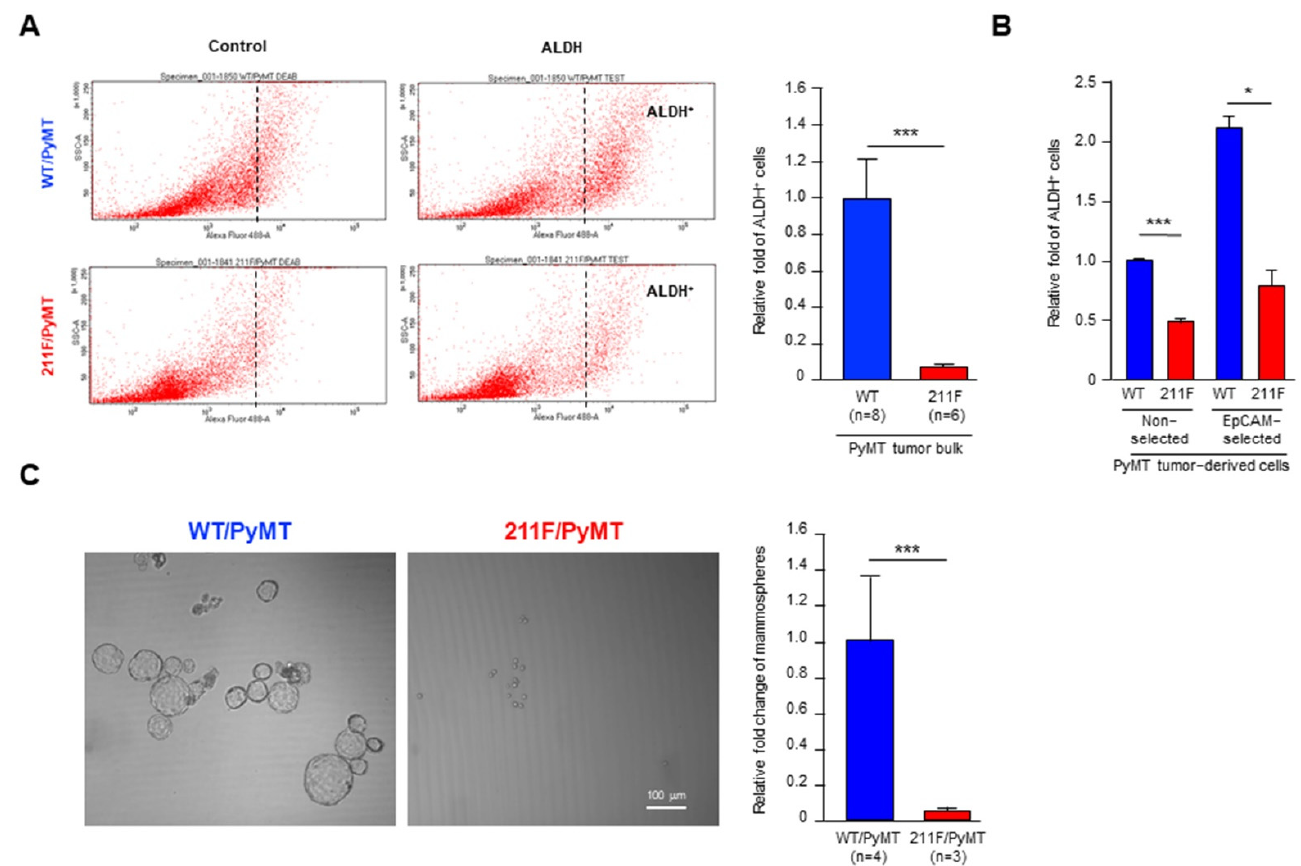
Figure 3. Y211 phosphorylation is important for maintaining the stemness of cancer cells in vitro. ( A ), Left, representative plots of the ALDH + cell sub-population isolated from WT/PyMT and 211F/PyMT tumor tissues. Right, data from multiple tumors of each genotype were quantitated and plotted. The numbers of mice are indicated (n). ( B ), Bulk cell populations were independently isolated from a pair of WT/PyMT and 211F/PyMT tumor tissues, and their ALDH activities were compared either in the straight cell population (non-selected) or in the cell population after enrichment for epithelial cells by EpCAM pull-down (EpCAM − selected). The data derived from three independent pairs of tumor tissues were quantitated and plotted. Bar, standard deviation. *, p < 0.05, ***, p < 0.005 as determined by Student’s t − test. ( C) , Left, representative images of mammosphere formation by WT/PyMT and 211F/PyMT cells. Right, result quantification showed that mammosphere formation was compromised in 211F/PyMT. ***, p < 0.005 as determined by Student’s t − test.